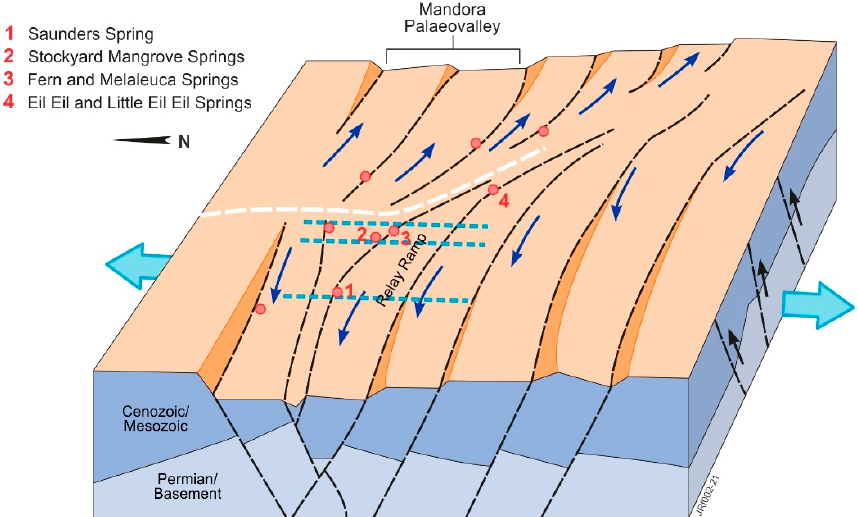
Figure 4. Conceptualization of fault structures in the 2016 AEM 1D LEI Inversion area (adapted from [29,49]); AEM flight lines L40015, L40026 and L40027 (west to east) are blue dashed lines; spring sampling locations are in red; black arrows depict uplift in the Anketell Shelf area and relay fault movement is denoted by blue arrows, with the connecting fault (accommodation zone) in white.